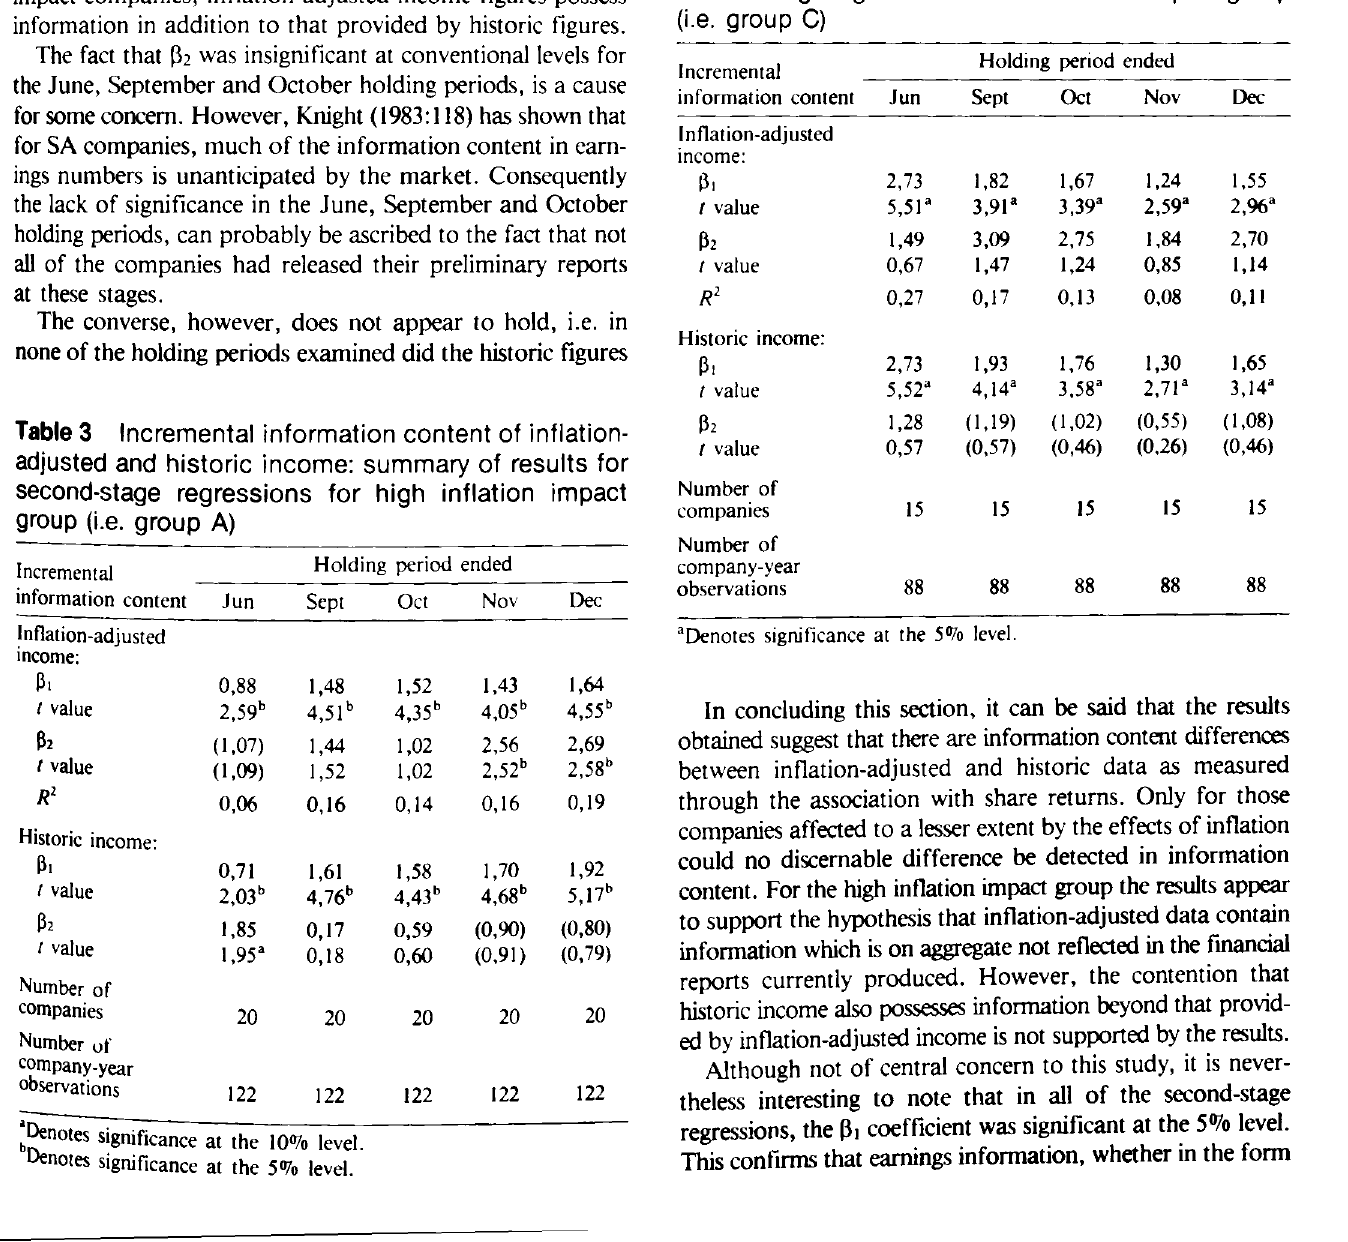
Incremental information content of inflation- adjusted and historic income: summary of results for second-stage regressions for low inflation impact